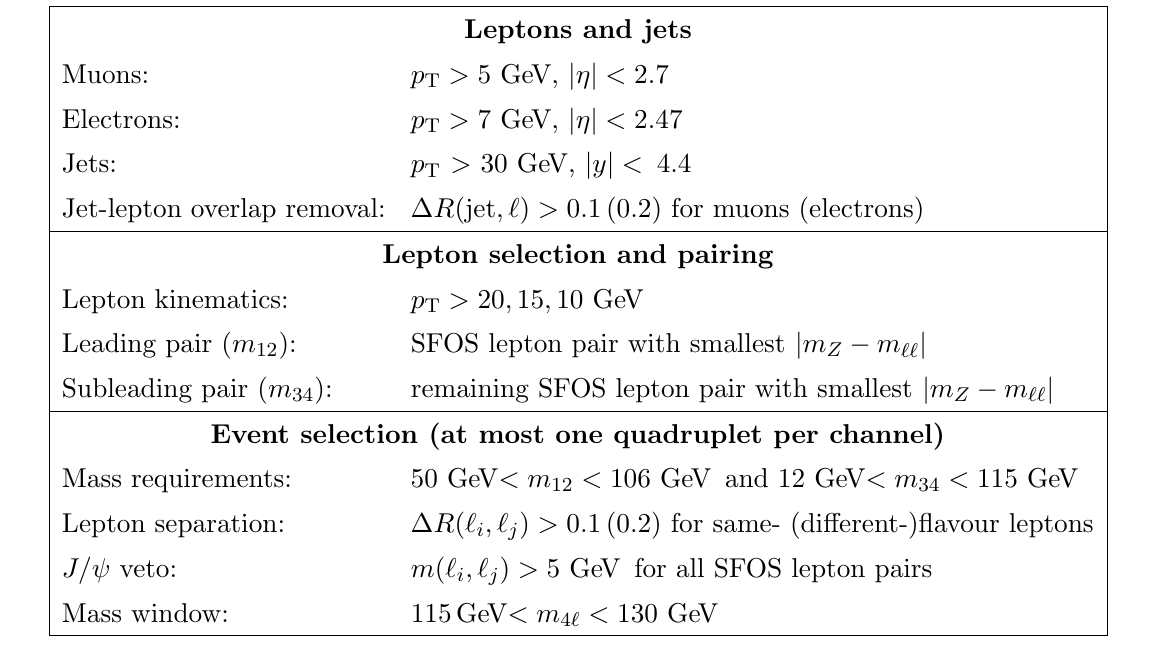
The (cid:12)ducial selection is applied to (cid:12)nal-state 3 electrons and muons that do not orig- inate from hadrons or (cid:28)